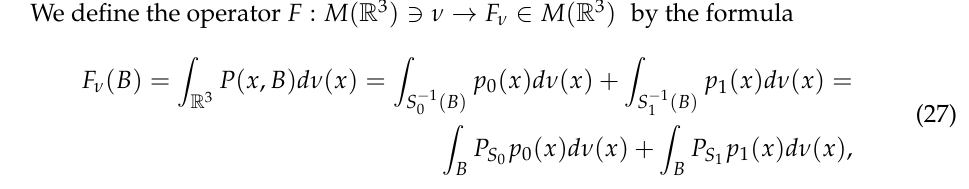
Figure 3. Figure presents the results obtained for the system (12) with a = 1 initial conditions ( ξ 1 ( 0 ) , ξ 2 ( 0 ) , ξ 3 ( 0 )) = ( 0,0,0 ) and constant probabilities p 0 ( x ) ≡ 0.5, p 1 ( x ) ≡ 0.5 after 100,000